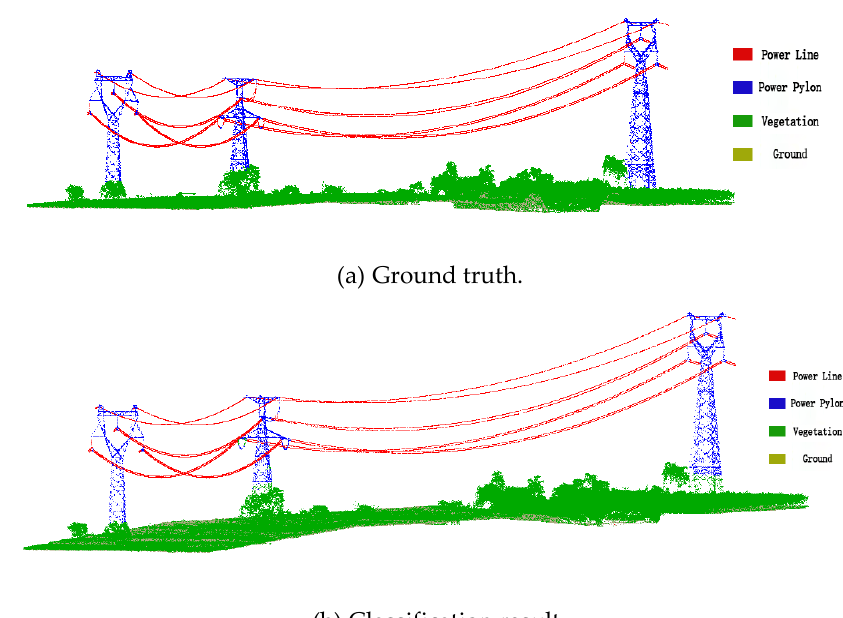
(b) Classification result.